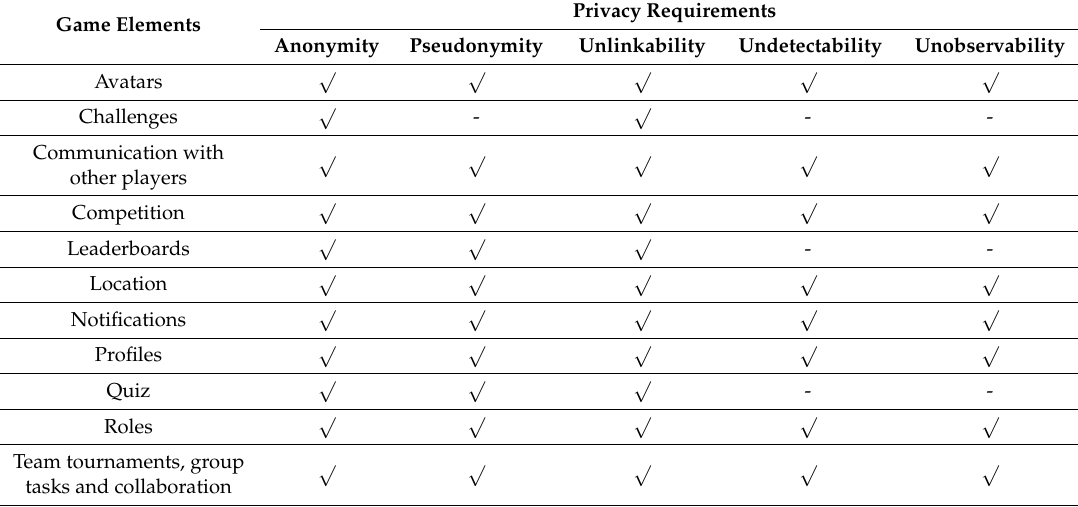
Table 2. Matching Game elements with Privacy